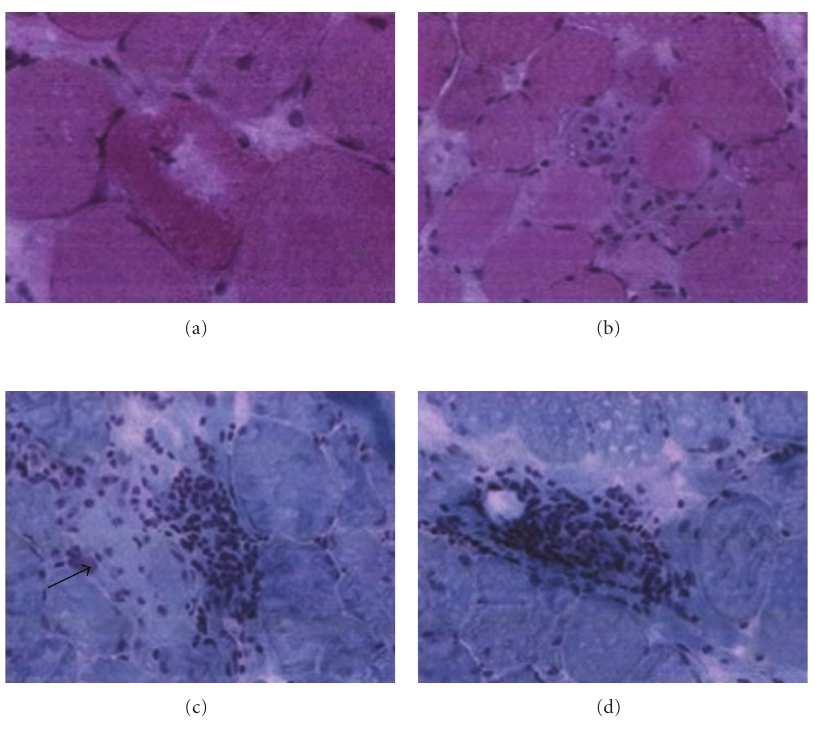
Figure 1: Muscle biopsy: (a) vacuolated fibers, (b) necrotic fibers, (c and d) endomysial and perivascular inflammation as well as necrotic fibers (black